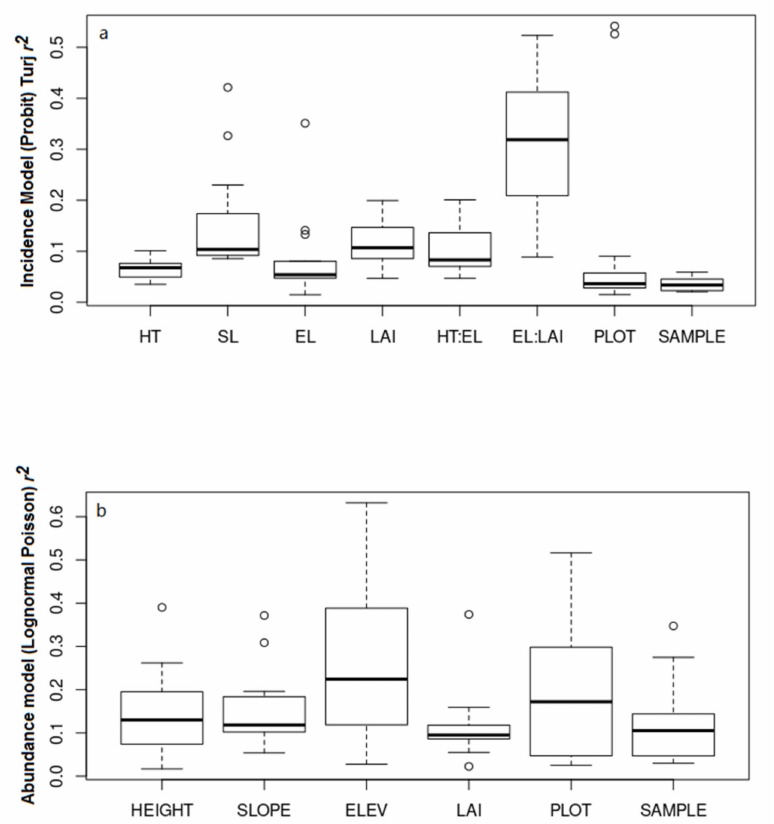
Figure 1. Box and whisker plots illustrating the proportion of variance in trap captures explained by environmental variables across species; ( a ) Incidence model (Probit); ( b ) Abundance model (Lognormal Poisson). Only species with a predictive r 2 of >0.10, based on a 5-fold cross-validation, were included. Models were estimated using Hierarchical Modeling of Species Communities (HMSC; Ovaskainen et al. 2017